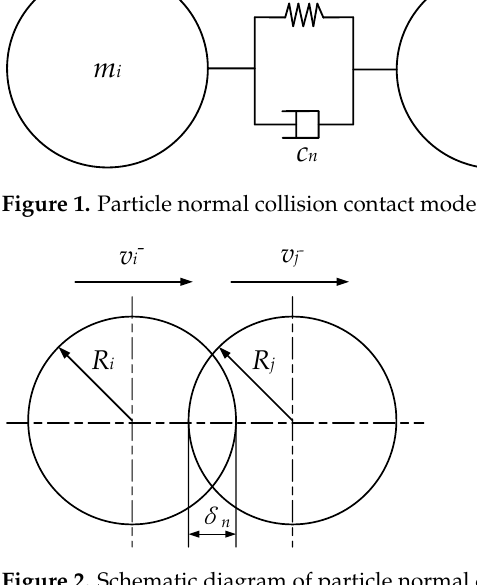
Figure 2. Schematic diagram of particle normal collision.